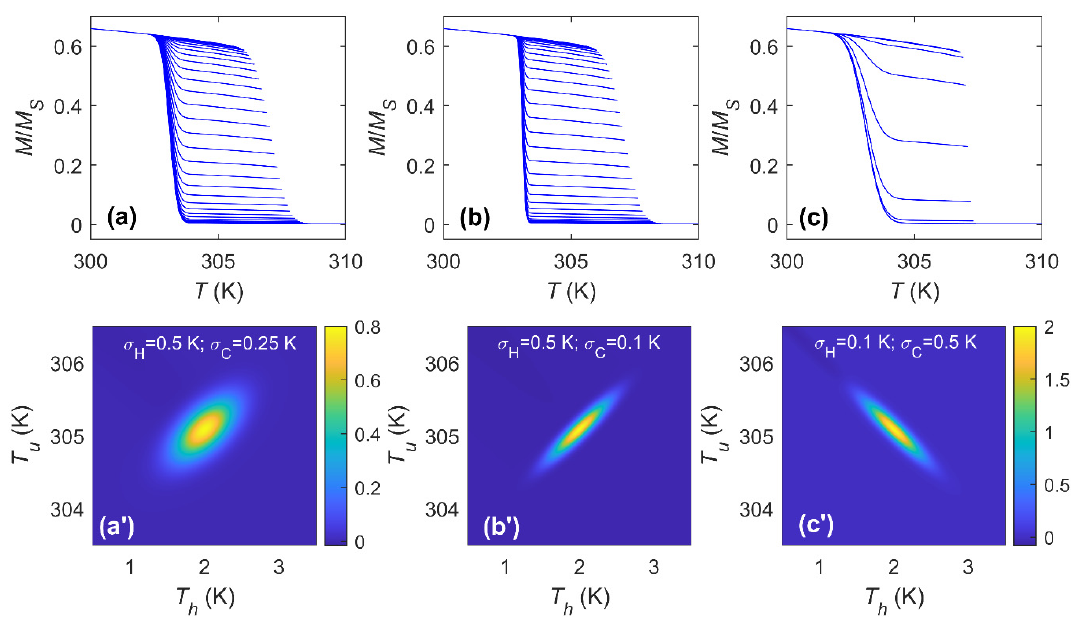
Figure 5. Cooling first order reversal magnetization curves and associated TFORC distributions with (cid:2022) (cid:3009) = (cid:1846) (cid:3047),(cid:3020)(cid:3021) + 2 K , (cid:2022) (cid:3004) = (cid:1846) (cid:3047),(cid:3020)(cid:3021) − 2 K (skewness not considered) for ( a )–( a’ ) (cid:2026) (cid:3009) = 0.5 K and (cid:2026) (cid:3004) = 0.25 K , ( b )–( b’ ) (cid:2026) (cid:3009) = 0.5 K and (cid:2026) (cid:3004) = 0.1 K and ( c )–( c’ ) (cid:2026) (cid:3009) = 0.1 K and (cid:2026) (cid:3004) = 0.5 K .